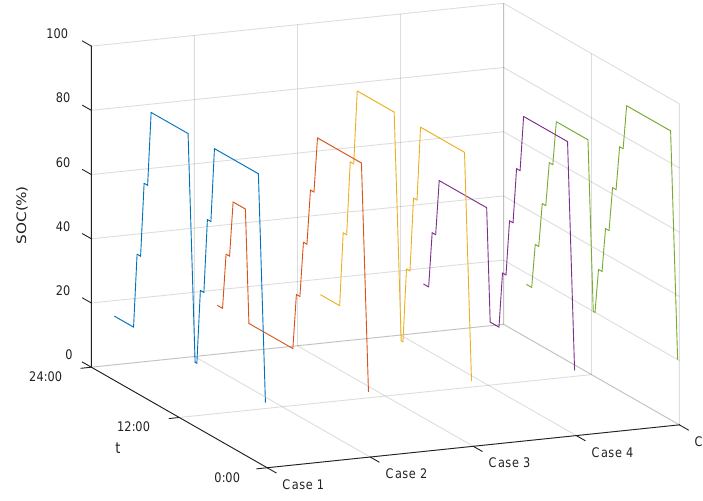
Figure 7. Day-head SOC curves of electric buses under different cases.